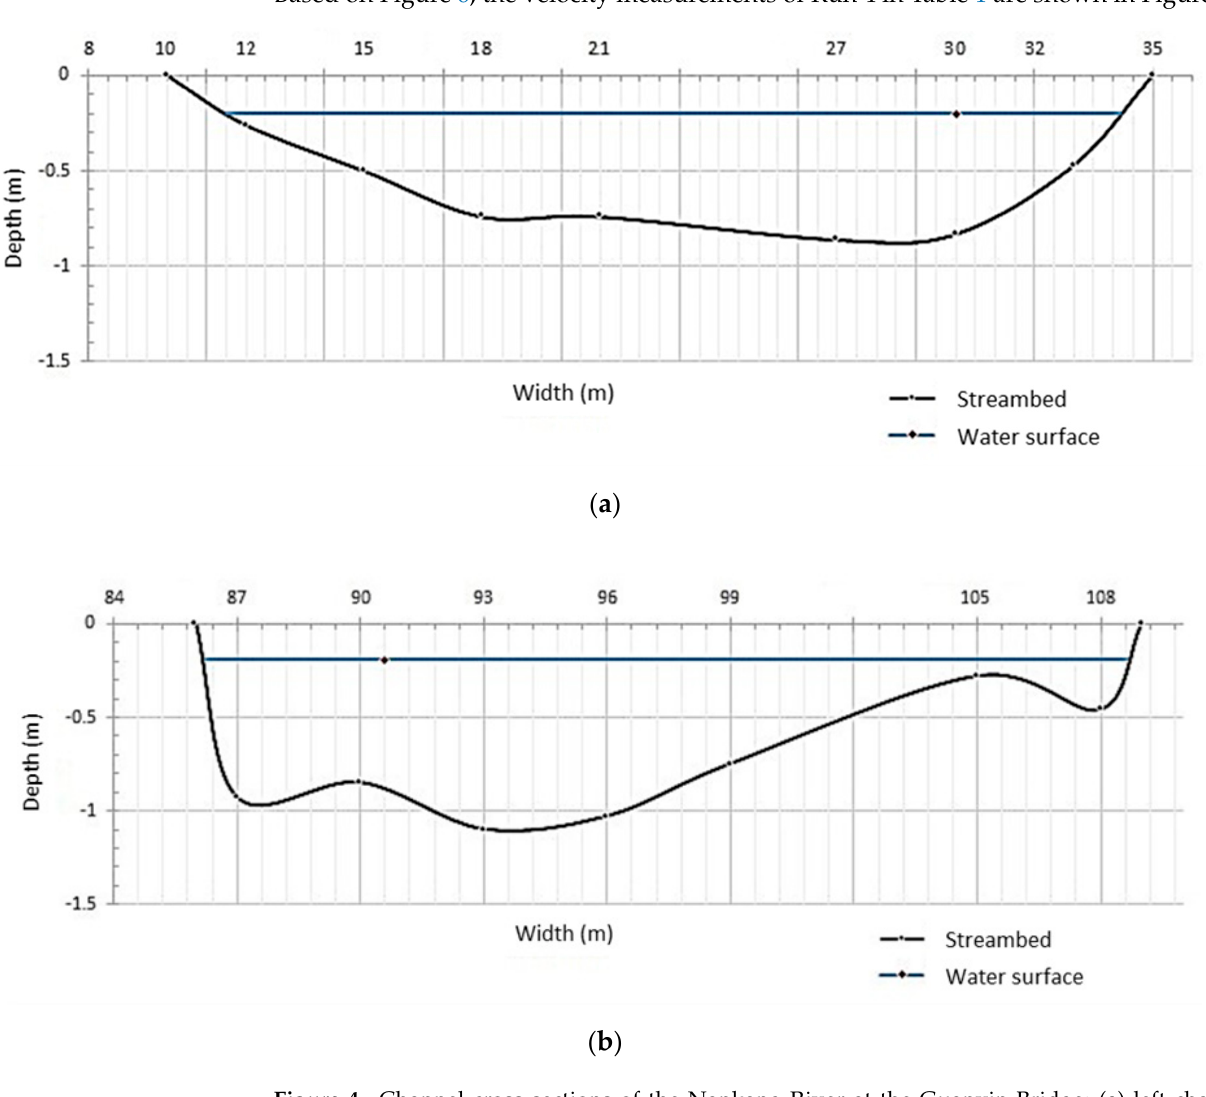
Figure 4. Channel cross sections of the Nankang River at the Guanyin Bridge; ( a ) left channel; ( b ) right channel.